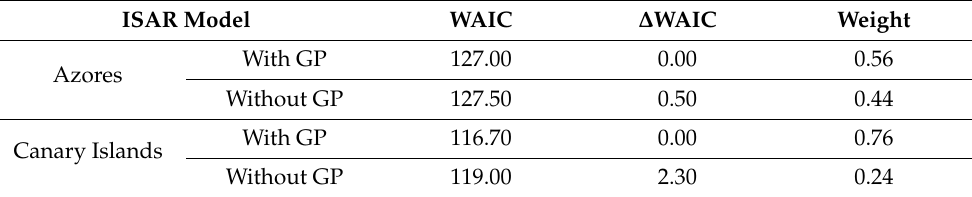
Table 3. Comparison of ISAR models using the “Widely Applicable Information Criterion” (WAIC). ∆ WAIC for model i is calculated as WAIC i —WAIC min , and “weight” is calculated as